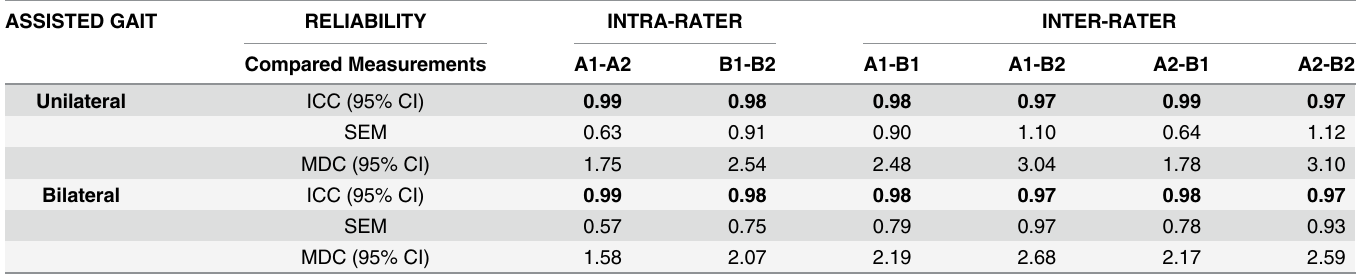
Table 3. ICC (95% CI), SEM and MDC (95% CI) of the compared measurements. ASSISTED GAIT